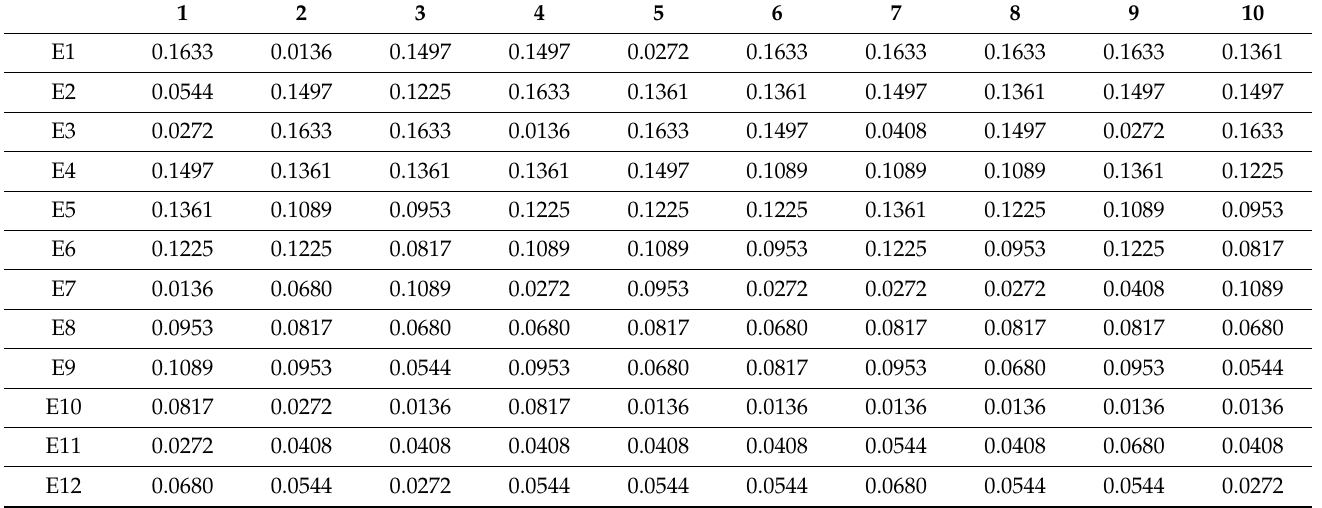
Table 4. Original Table 3. Table of case study results.